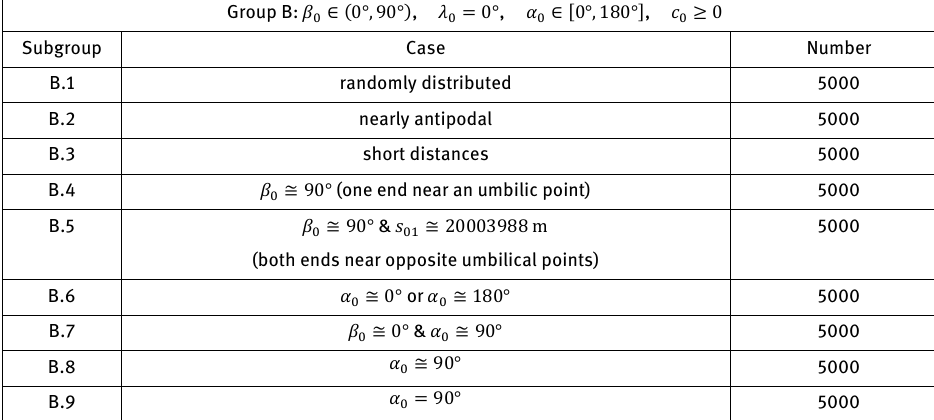
Table 6: Description of the geodesics in the Group B